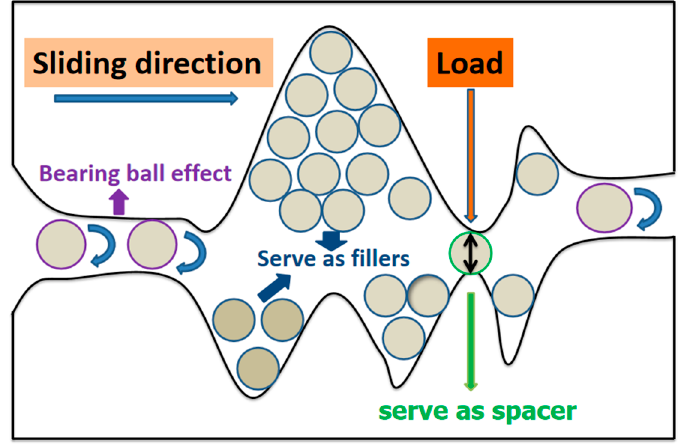
Scheme 2. Anti-wear mechanismatic of nano-TiO 2.